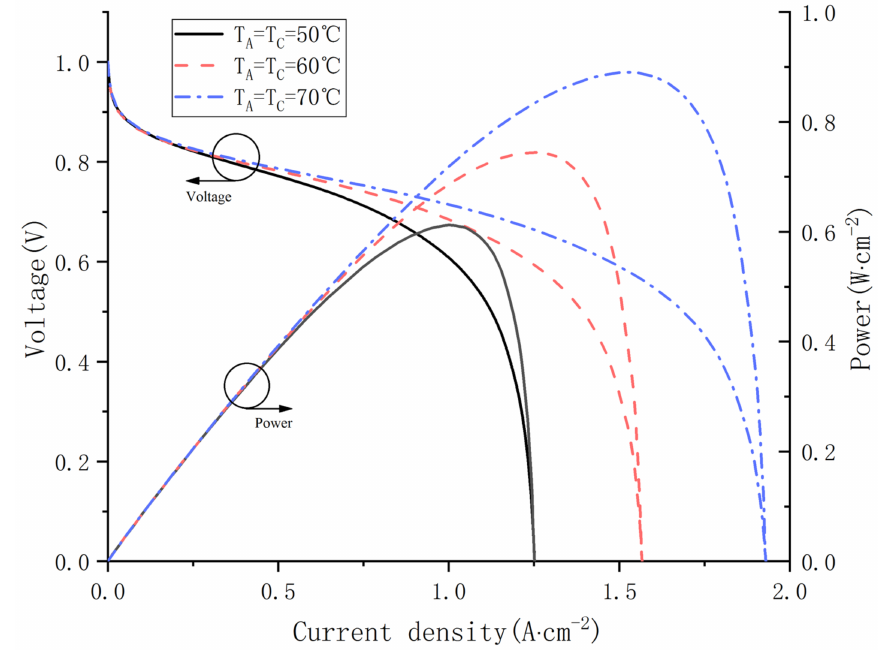
Figure 10. Polarization curves and power curves at different operating temperature.